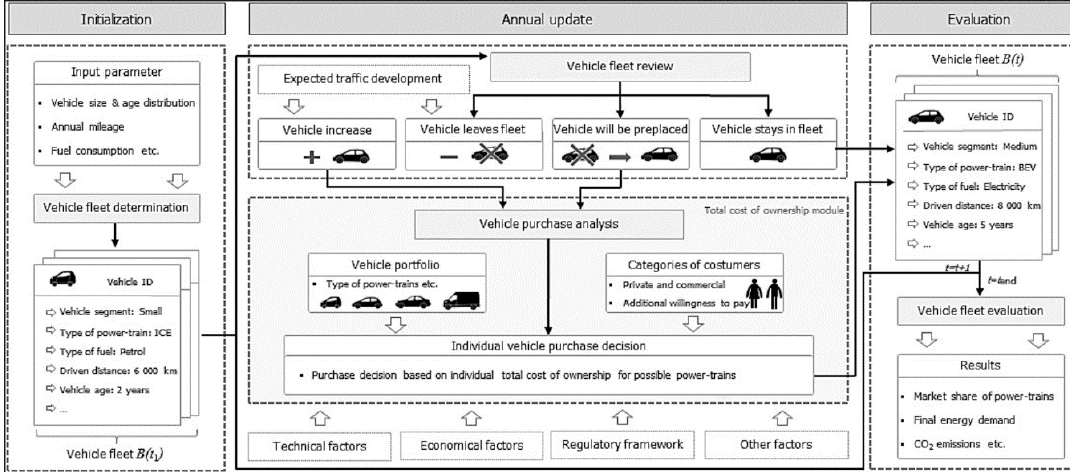
Figure 2. Schematic representation of the vehicle fleet model [22].